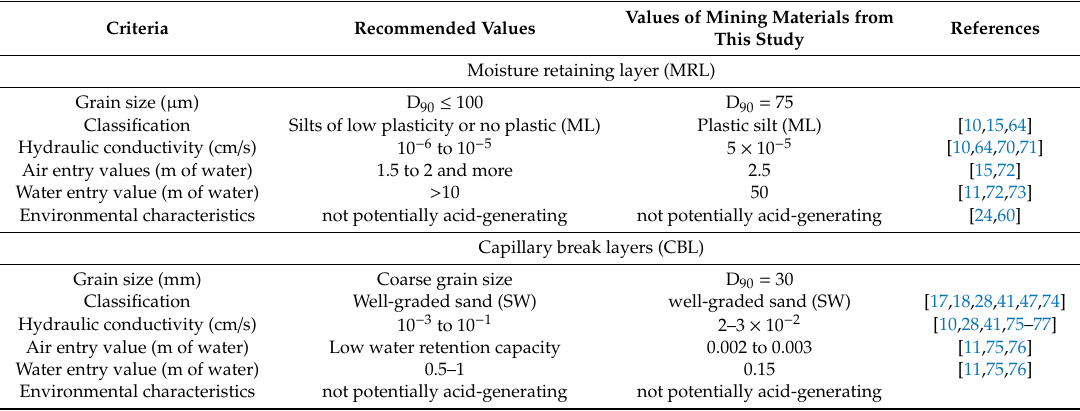
Table 5. Criteria for choosing materials for covers with capillary barrier e ff